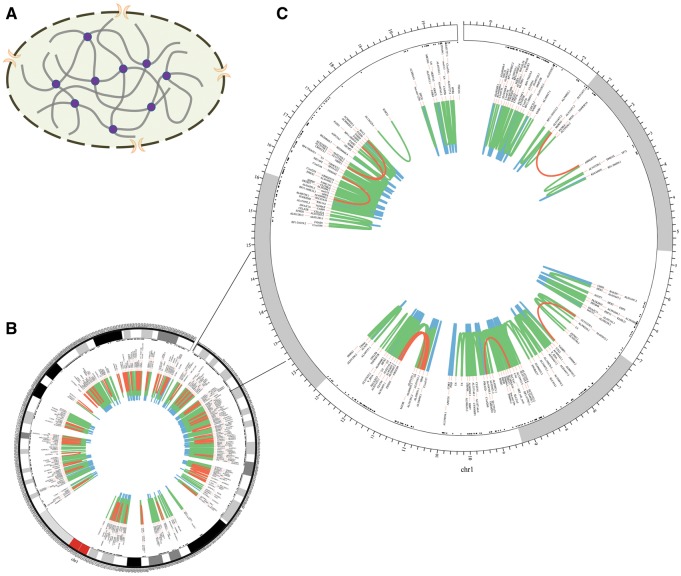
Chromosomal 3D structure and promoter–promoter interactions of Chr1 in IMR90 cell line based on a set of Hi-C data. (A) Chromosomal 3D structure. The dashed circle with two orange crescents that stand for nuclear pore complex is the nucleus membrane. The thick grey lines are chromatin and the purple circles stand for proteins that link chromatin together. (B) Promoter–promoter interactions of Chr1. (C) Promoter–promoter interactions of Chr1:1-20000000, zooming into the interactions. The red lines stand for long-range interactions (distance between interaction pair > 500 kb), while the blue lines for short-range (distance < 50 kb) and the green lines for middle-range (distance spanning 50–500 kb). The black texts are the gene names of corresponding loci.